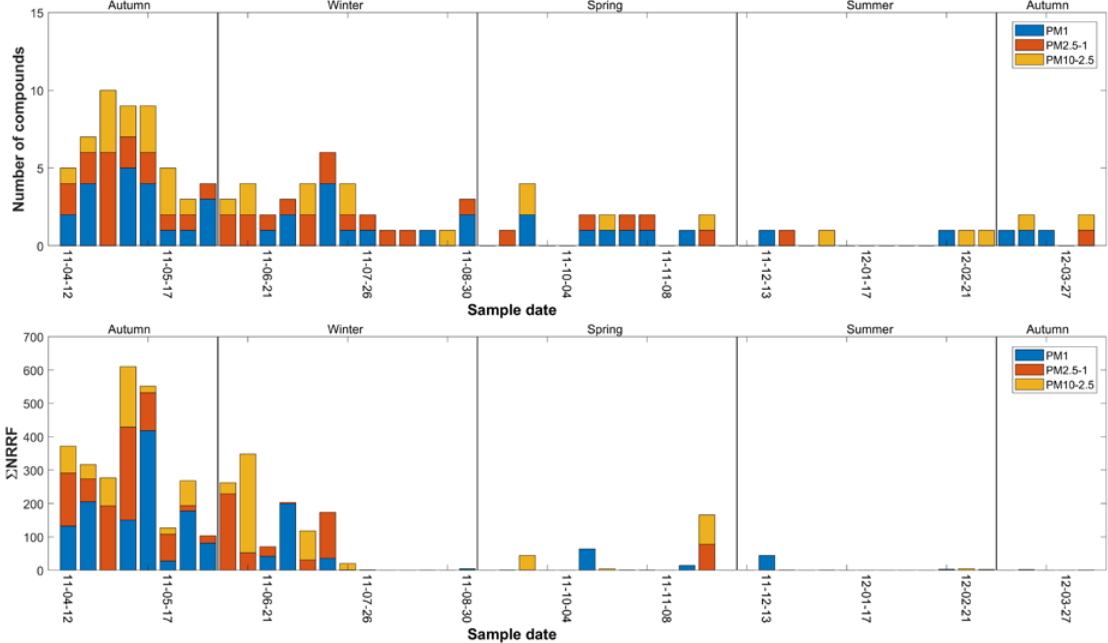
Figure 3. Total number of nitriles identified and their corresponding semi-quantified concentrations ( Σ NRRFs) in the three particle size fractions for each sample collected.